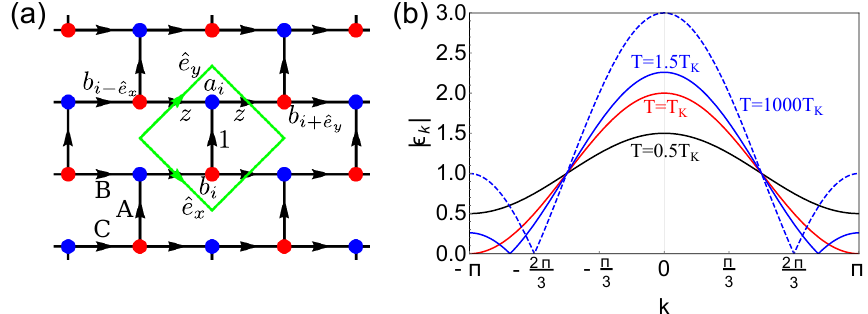
| [ Eq. 42 ] , for H [ Eq. 32 ] in Figure 16: The brick lattice and Kasteleyn-matrix spectrum, | ε ABB k the constrained manifold. (a) Bond directions (black arrows) are chosen so as to respect Kasteleyn’s theorem [ 46 ] , and bond weights are chosen to be z on B and C bonds and 1 on A bonds, in accordance with Z hon [ Eq. 36 ] . The i th unit cell (green) contains two sites with associated Grassmann variables a i (blue) and b (red). The translation vectors of the unit cell are ˆ e x and ˆ e y , and these are taken to be unit i | is shown along the path k = ( k , k + π ) . For T < T length. (b) The spectrum | ε K (black) the spectrum k is gapped at all k , and this corresponds to the stripe-ordered phase. At T = T K (red) the gap closes at k = ( π ,0 ) and a Kasteleyn transition occurs. For T > T K (blue) the gapless point migrates from k = ( π ,0 ) to k = ( 2 π/ 3, − π/ 3 ) with increasing temperature, and the location of this gap is related to the density of strings, n string [ Eq. 45 ]